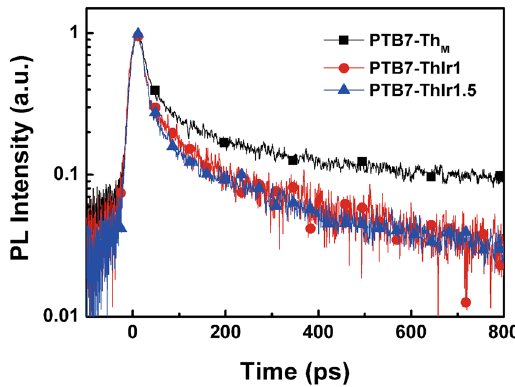
Fig. 5 Ultra-fast time-resolved PL transients taken at 850 nm (excitation wavelength of 650 nm) for representative polymer/ PC 71 BM blended fi lms re fl ecting the decay dynamics of excitons, and all the blended fi lms were prepared at the same conditions as